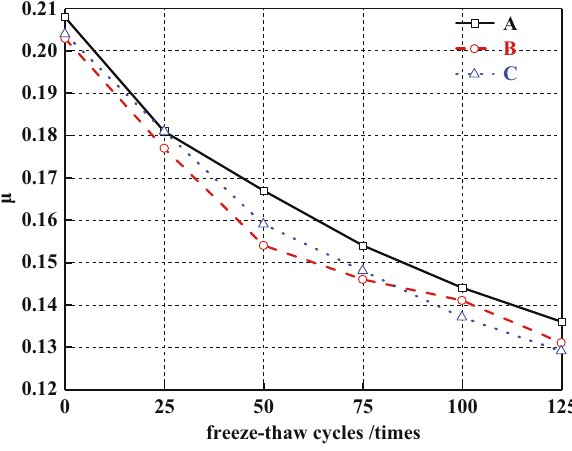
Figure 18: Relationship between μ and freeze – thaw